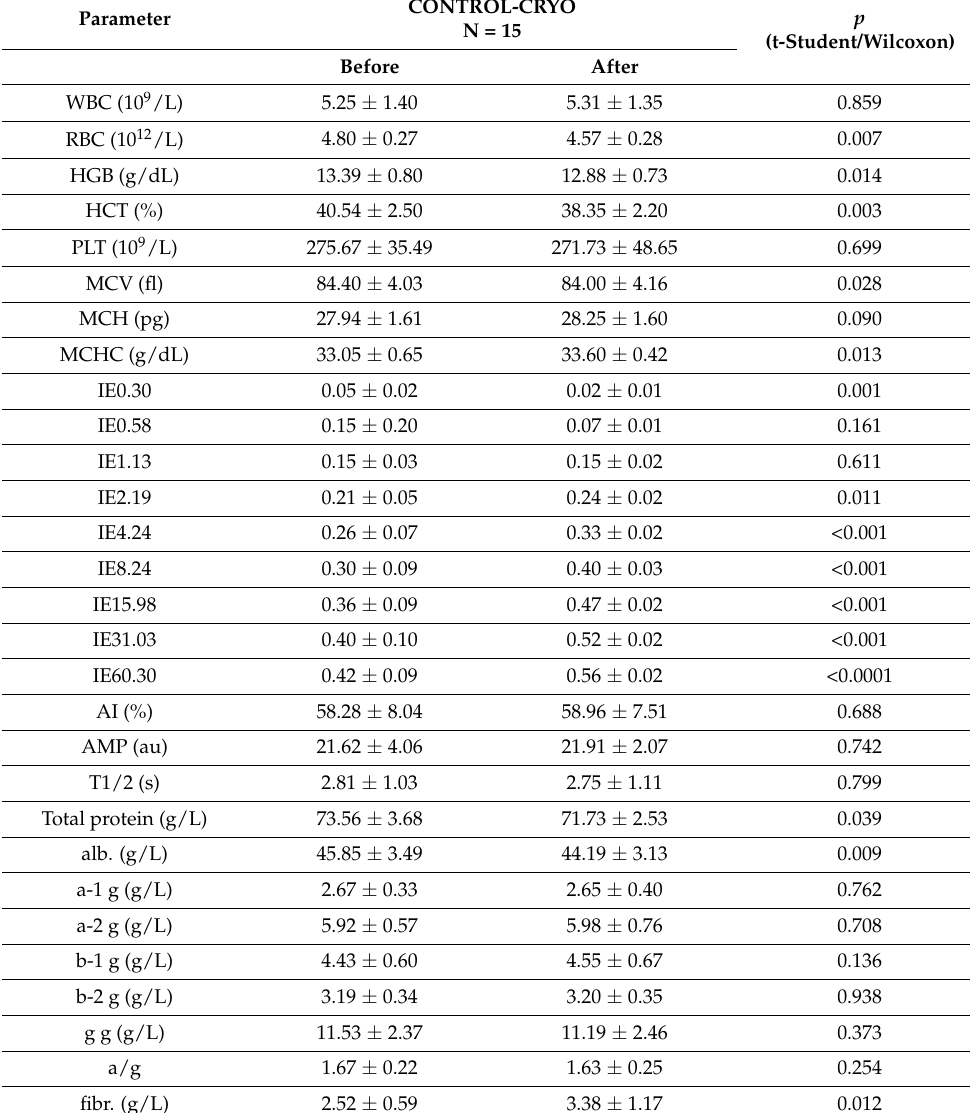
Table 5. Assessment of therapeutic intervention for